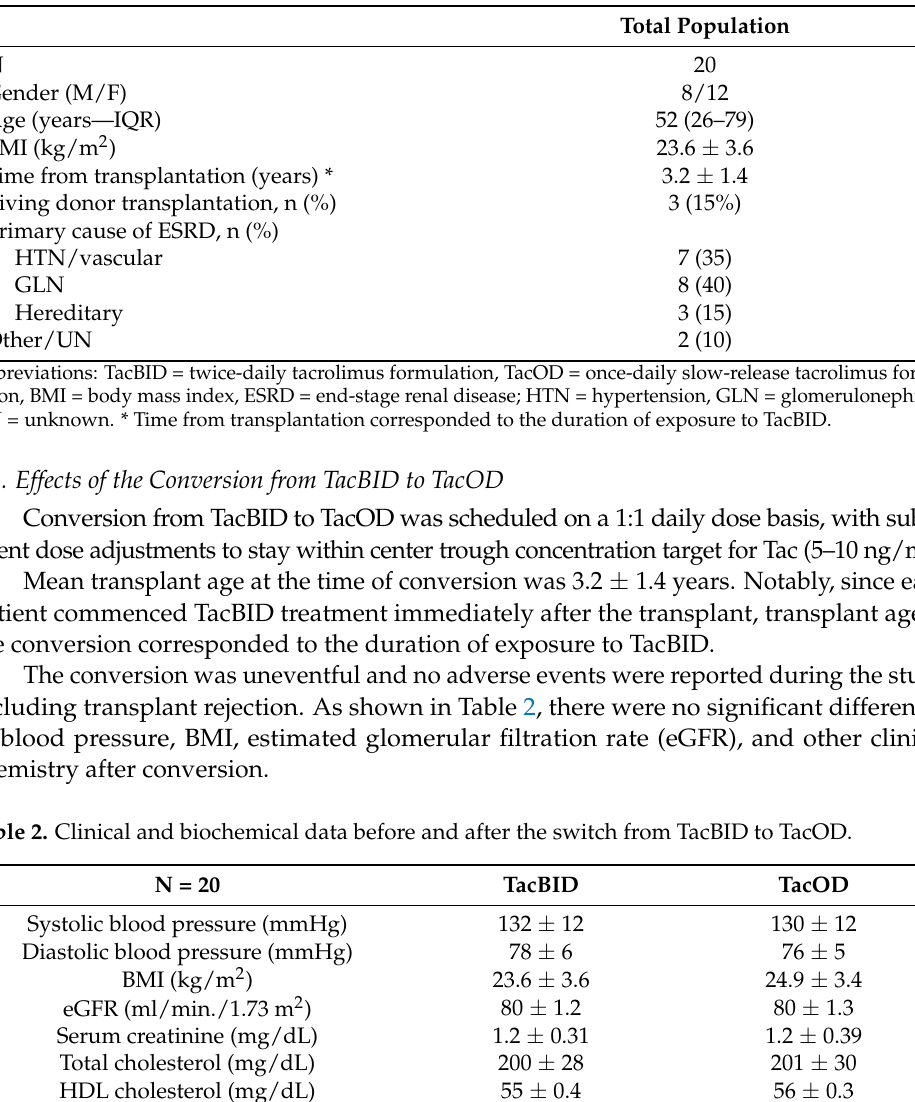
Table 1. Patient characteristics at the basal evaluation, before the conversion from standard twice-daily formulation of tacrolimus (TacBID) to the new once-daily slow-release formulation of tacrolimus (TacOD).